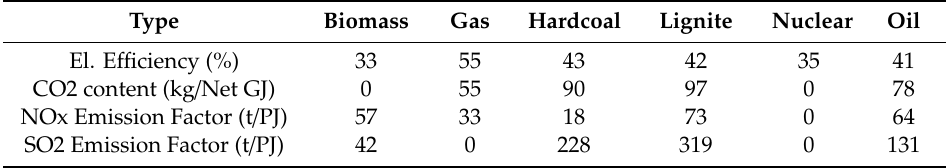
Table 3. Electrical e ffi ciencies, carbon content, and emission factors of NO x and SO 2 by technologies.